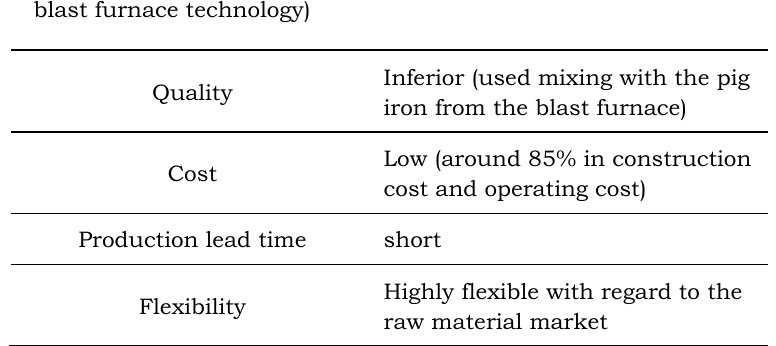
Table 3. Competitiveness of FINEX technology (when compared